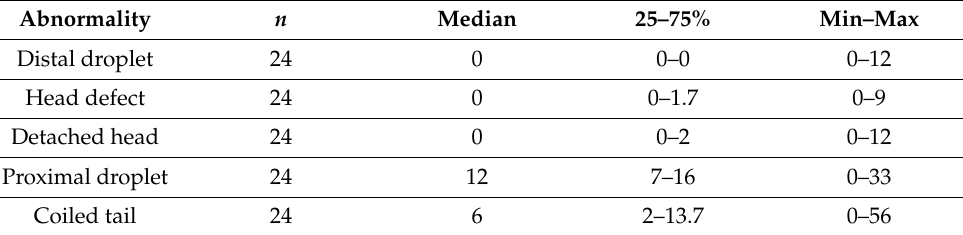
Table 9. Abnormal spermatozoa morphology (% total morphology) that was not different by time or treatment